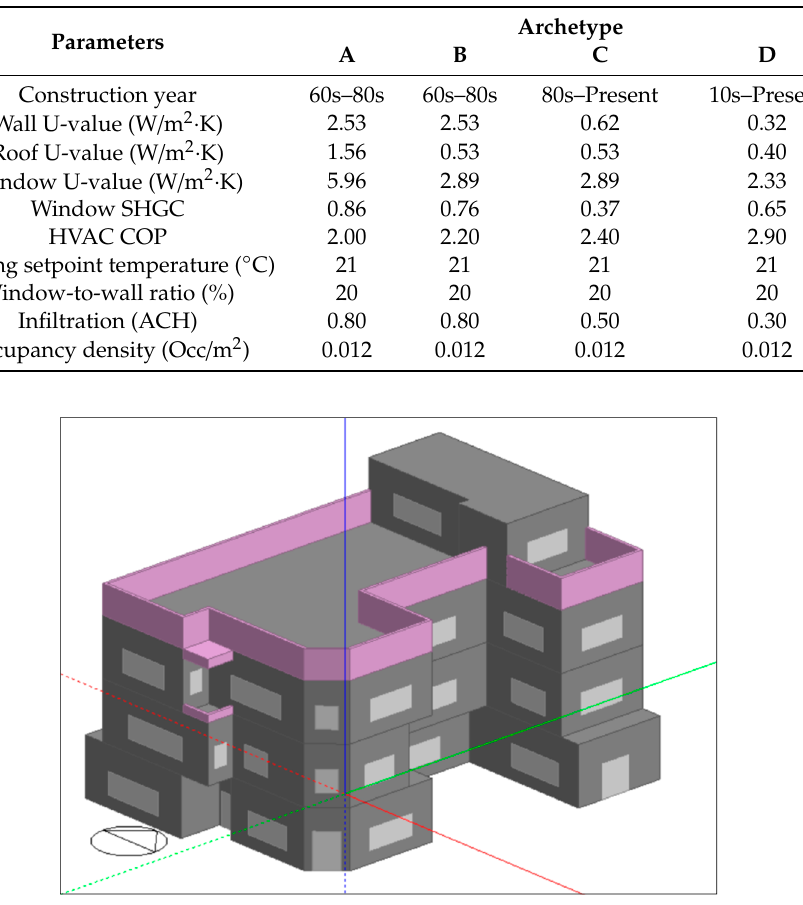
Table 1. Archetype parameters [34–36].